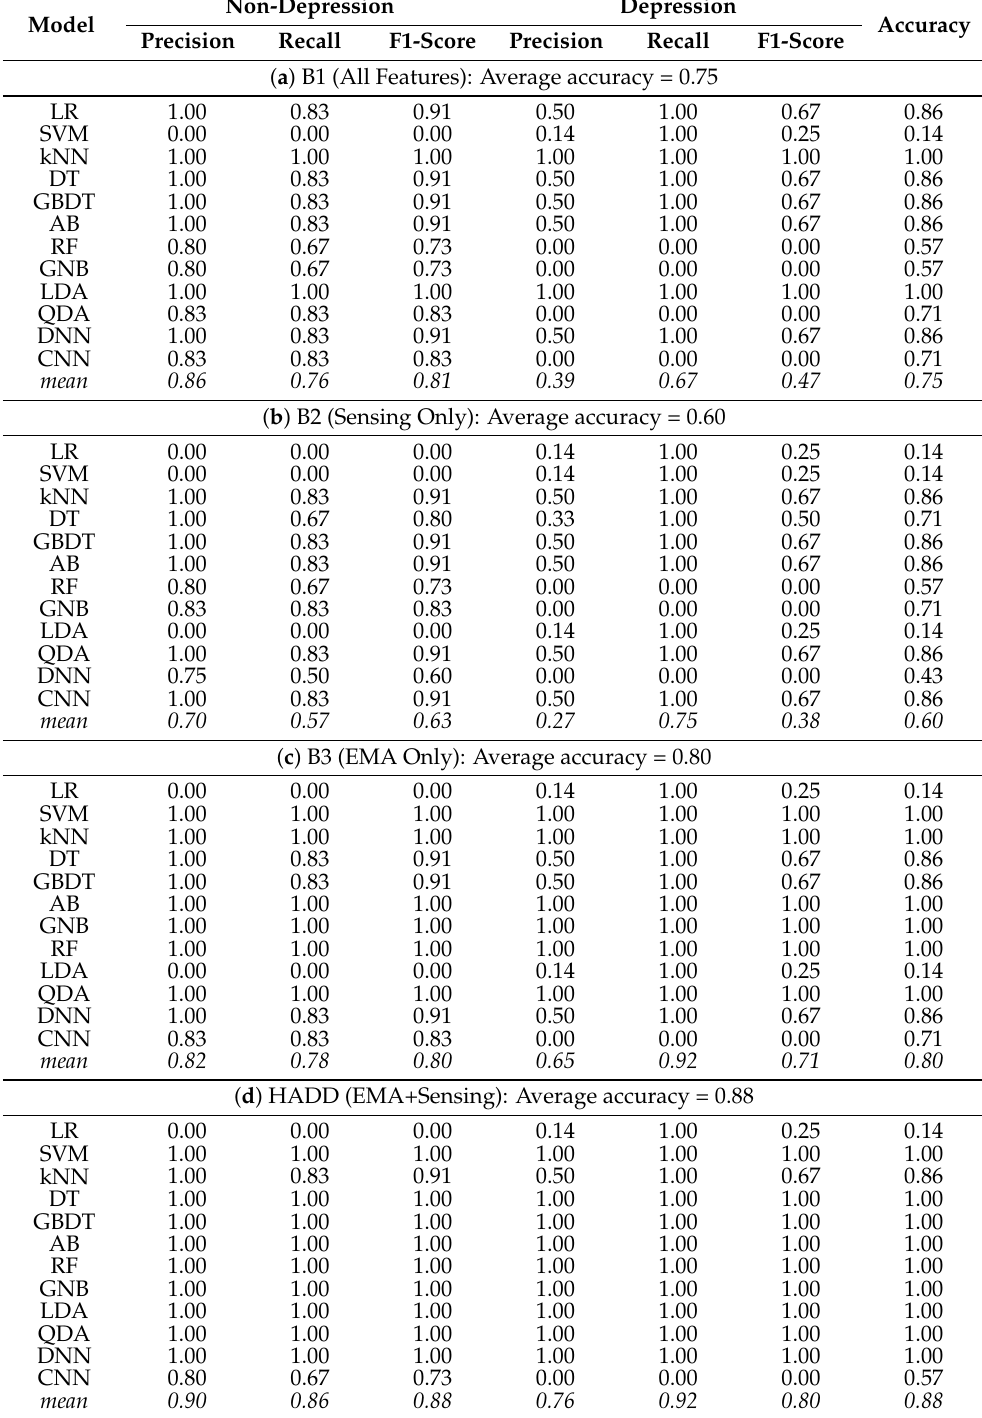
Table 3. Effectiveness of the multimodal approach of HADD based on feature selection. By analyzing key sensor and EMA features, HADD enhanced the accuracy by 8–28% in comparison with the state-of-the-art